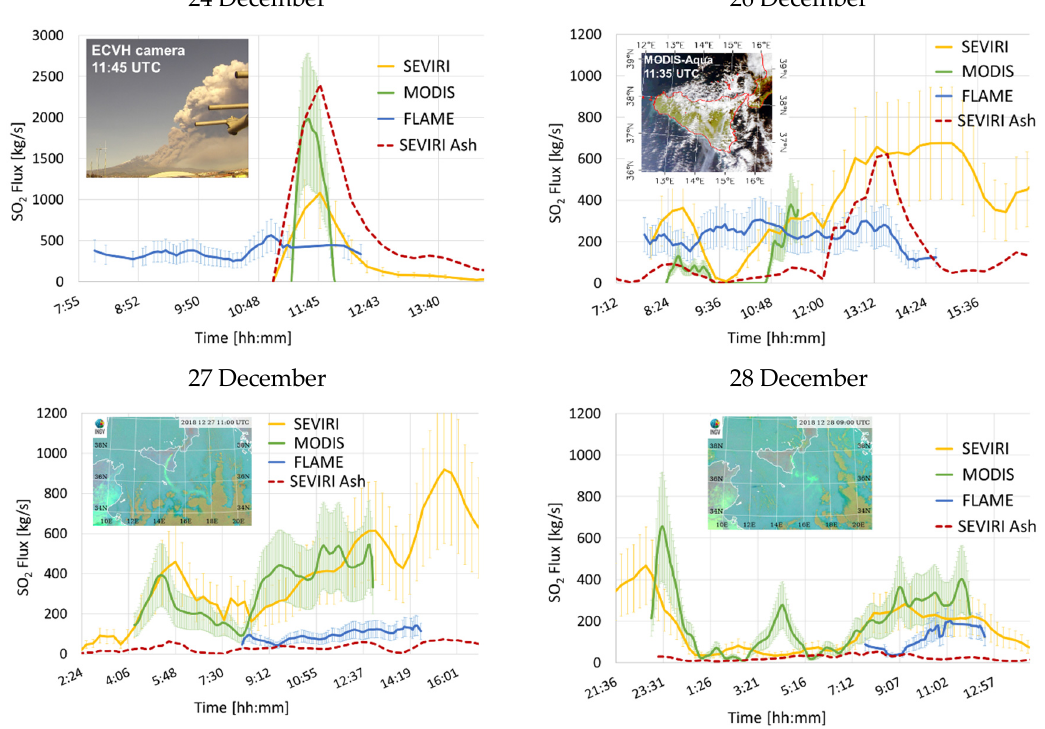
Figure 13. Detailed comparison of SO 2 fluxes for the 24, 26, 27, and 28 December observed by SEVIRI, MODIS, and FLAME. The dashed maroon line indicates the ash flux obtained from SEVIRI measurements.